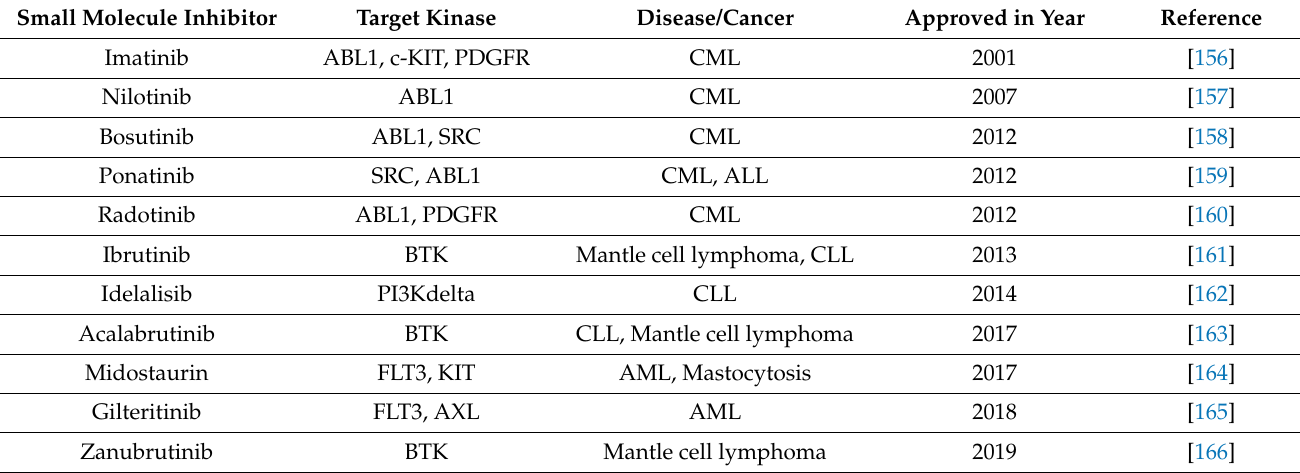
Table 4. List of a few examples of small molecule protein kinase inhibitors approved for clinical